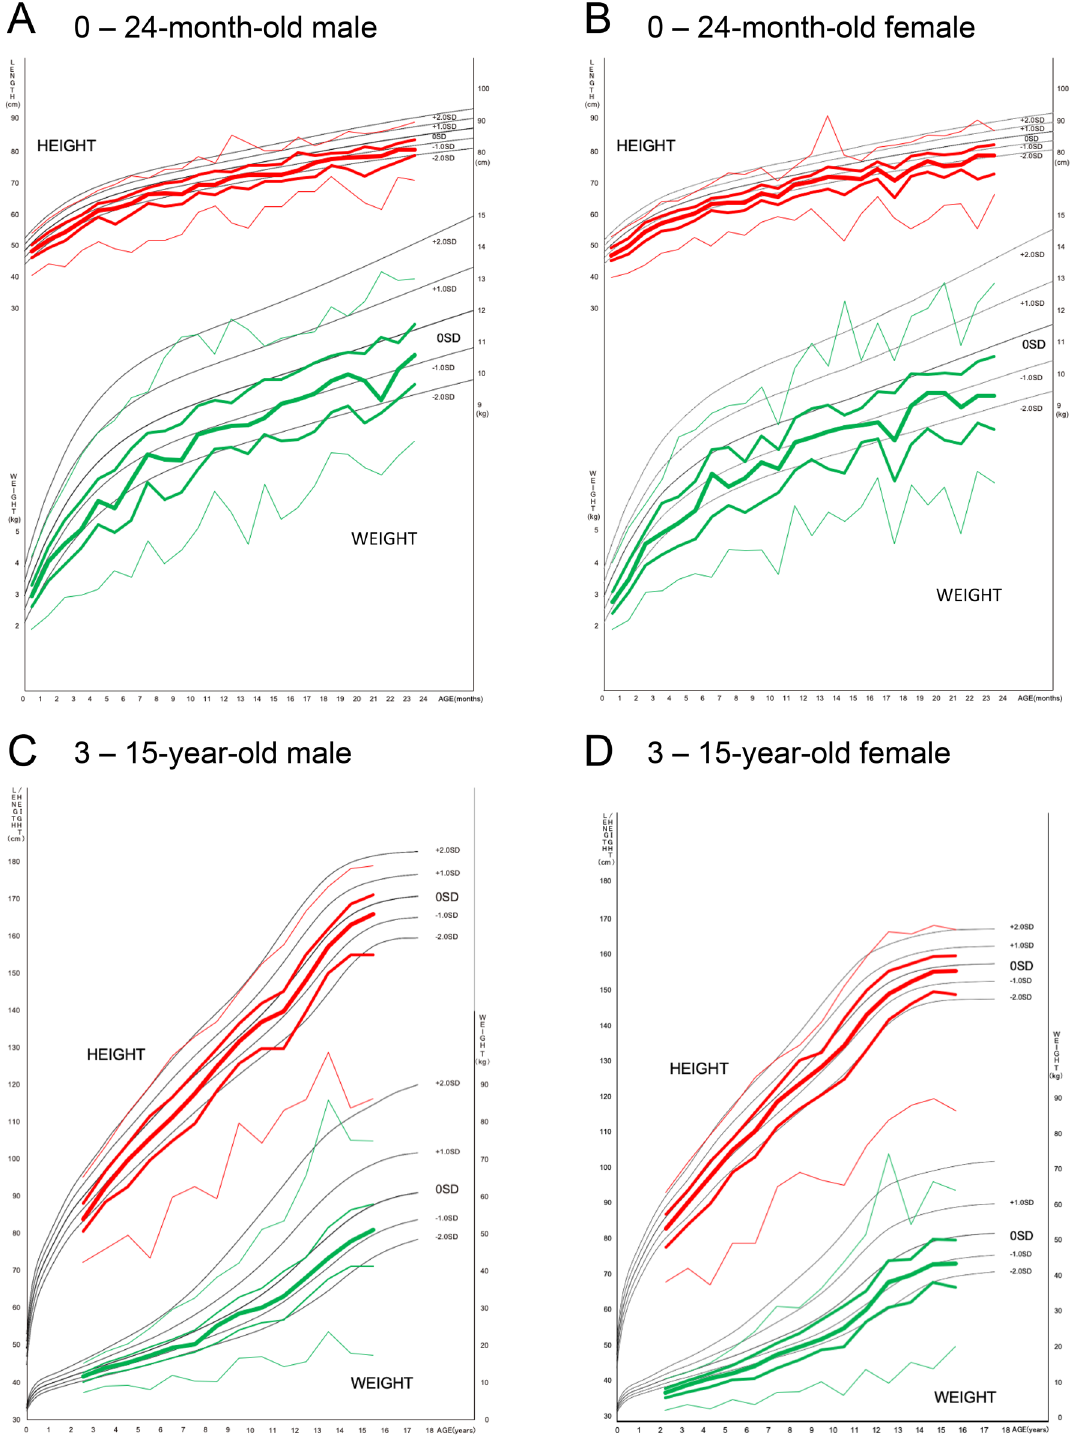
Figure 1. Percentile distribution of height and bodyweight of pediatric patients admitted to intensive care unit. Percentile distribution of height (red lines) and bodyweight (green lines) were overdrawn on the growth charts for Japanese children (black lines, reference #2. The charts were reproduced with official permission of the Japanese Society for Pediatric Endocrinology from Isojima et al. Growth standard charts for Japanese children with mean and standard deviation (SD) values based on the year 2000 national survey. Clin Pediatr Endocrinol 25: 71–76, 2016. ©JSPE). The 1st (fine), 2nd (middle), 3rd (bold), 4th (middle), and 5th (fine) lines from the top indicate 97.5 percentile, 75.0 percentile, 50 percentile, 25 percentile and 2.5 percentile, respectively. Crude data is shown in Supplementary material